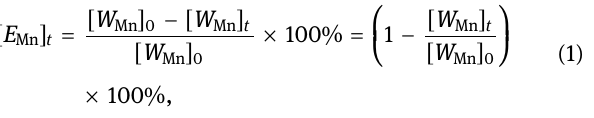
Table 2: Variation of steel sample quality at di ff erent temperatures Above liquidus temperature ( °C )